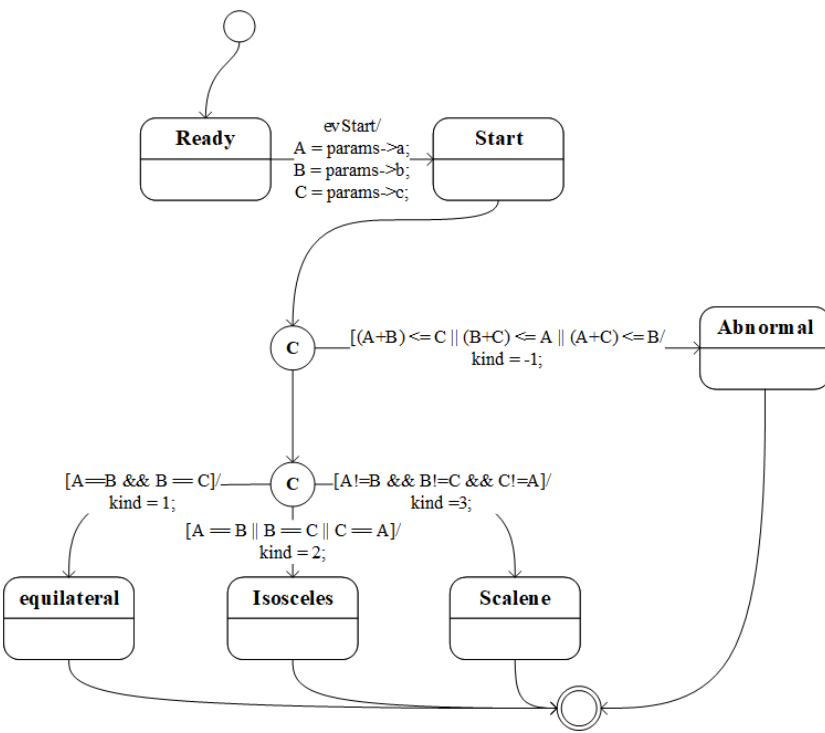
Figure 2. A state diagram of triangle